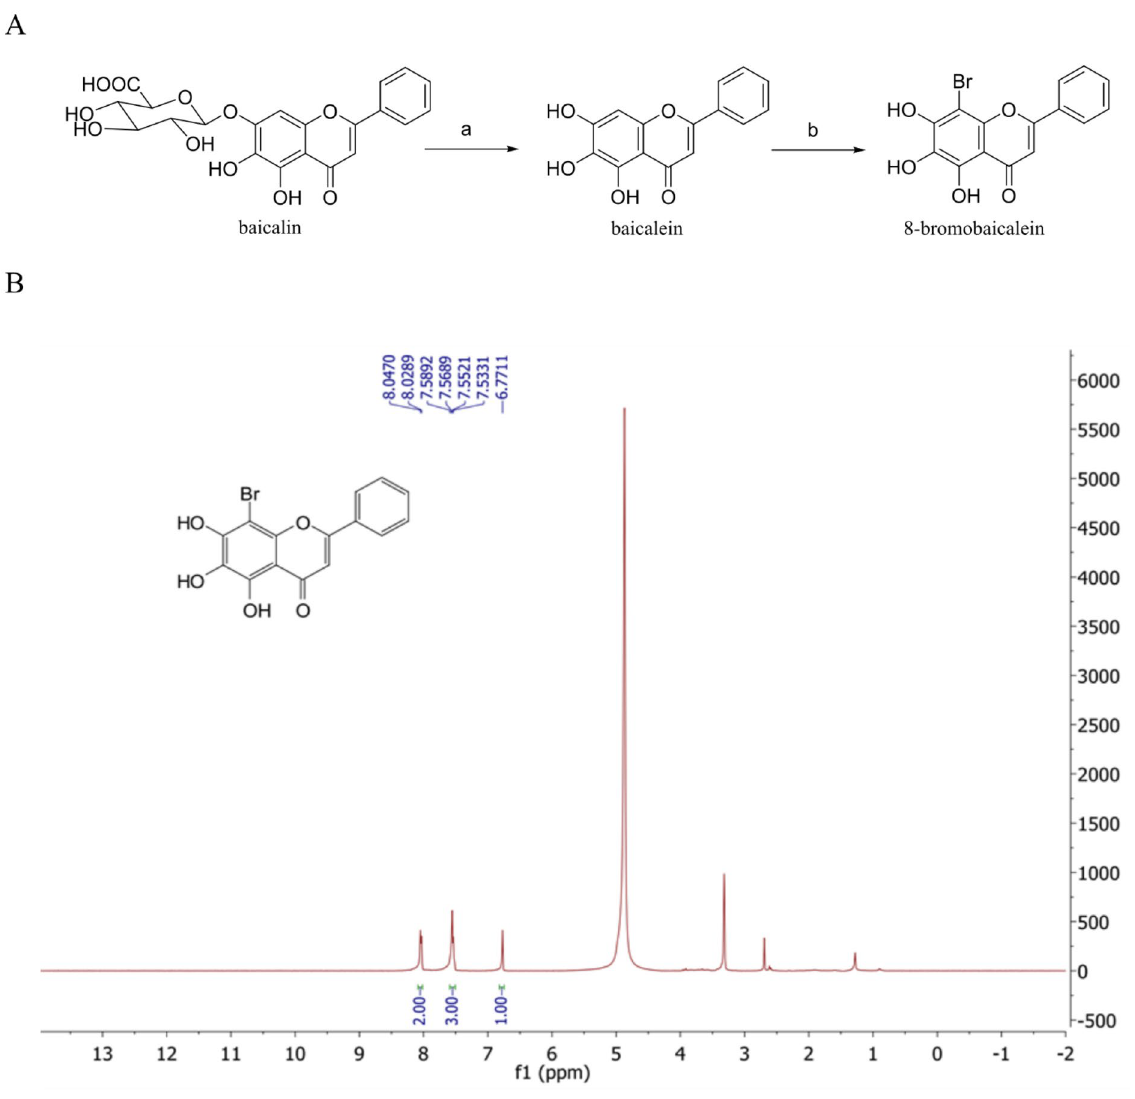
Figure 1. ( A ) Synthesis of an 8-bromobaicalein in a two-step process and ( B ) identification by 1 H-NMR (CD 3 OD, 400